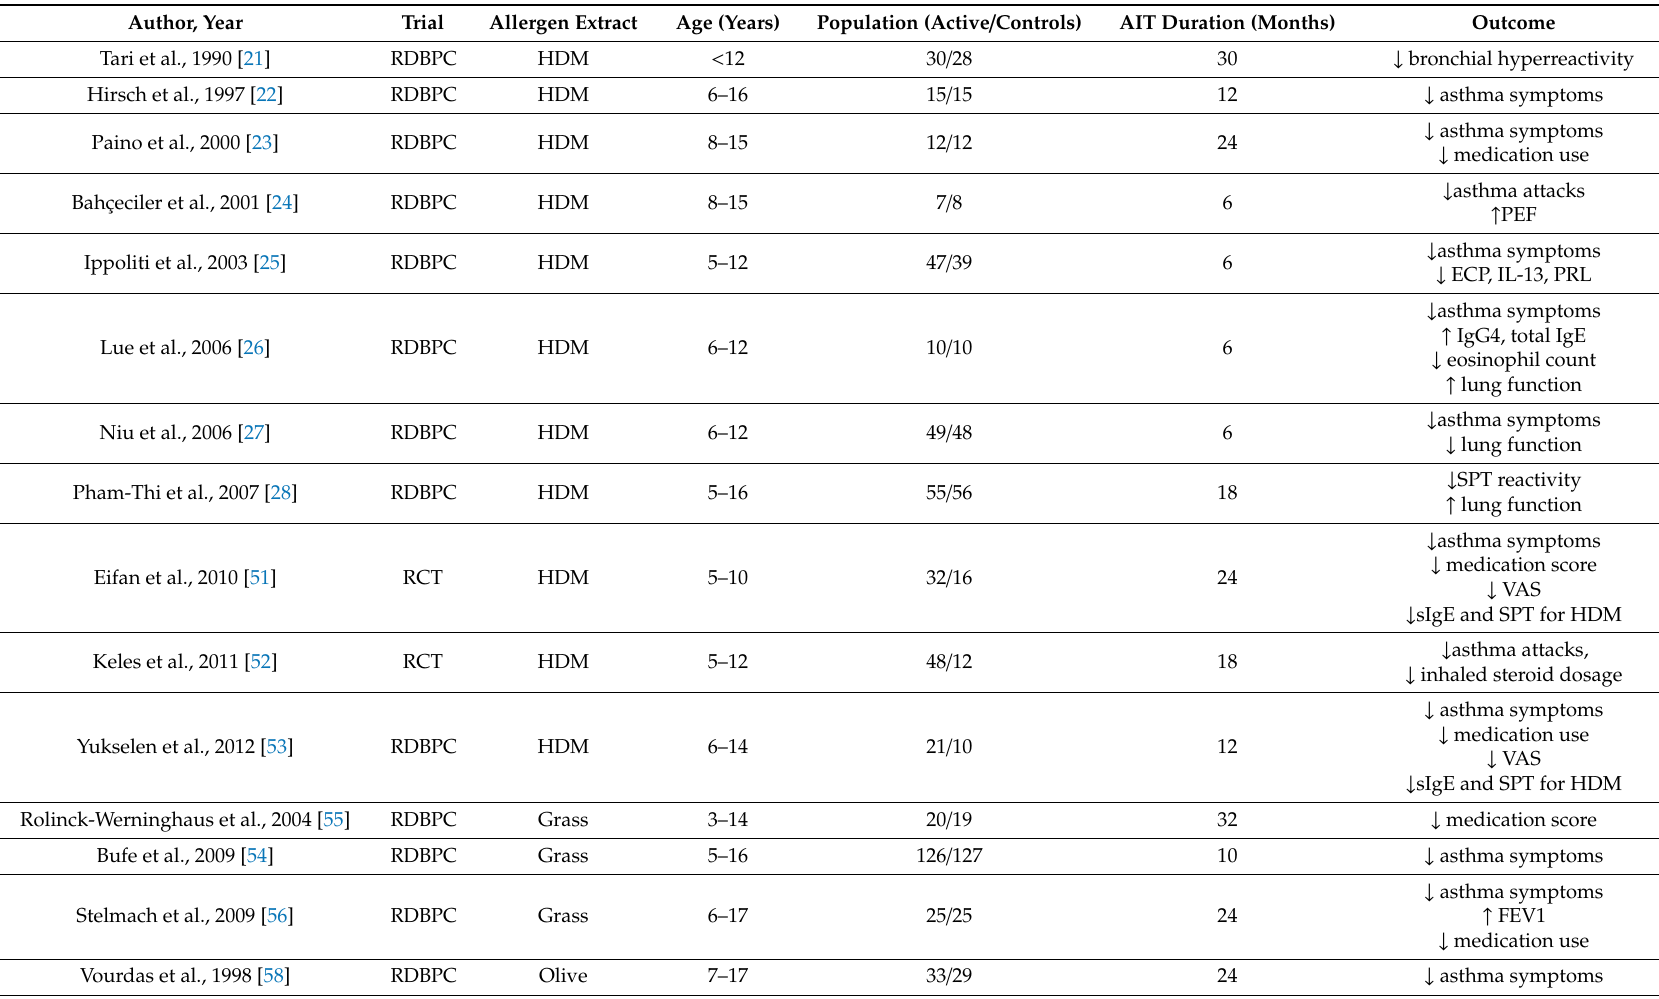
Table 1. Trials on SLIT e ffi cacy carried out in children with